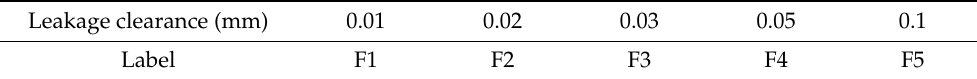
Table 5. Speed regulating valve leakage clearance.